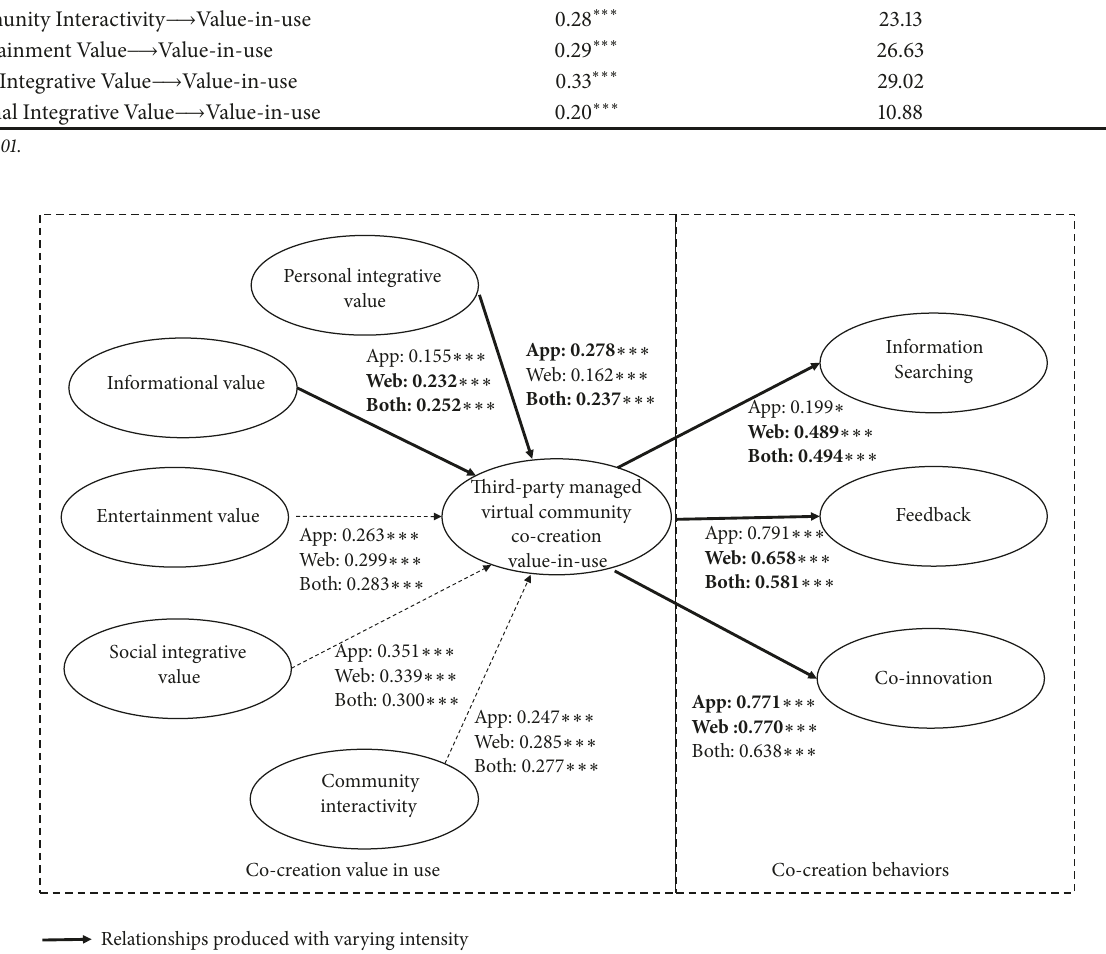
Figure 2: Relationship model.